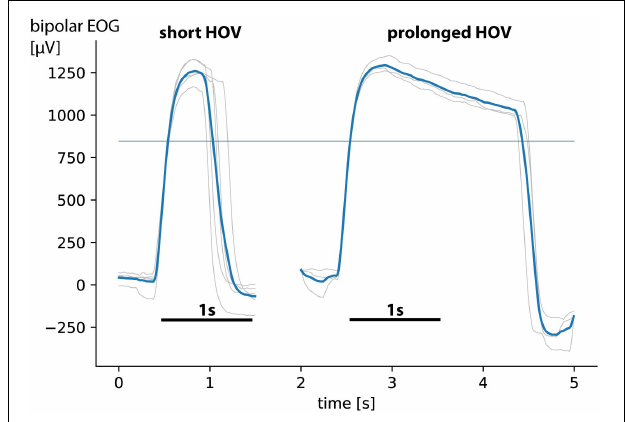
FIGURE 2 | Experimental setup. Participants were equipped with a wireless active-electrode electroencephalography/electrooculography (EEG/EOG) recording system (actiCAP R (cid:13) , LiveAmp R (cid:13) , Brain Products GmbH, Gilching, Germany) and comfortably seated in front of a screen receiving visual feedback. Feedback included information about the task to be executed (in the middle of the screen) and the representation of the left (partly opened yellow circle indicates active exoskeleton) and right exoskeleton (partly opened gray circle indicates inactive exoskeleton) visualizing opening or closing motions. The figure shows an EOG electrode laterally placed to left outer cantus and five EEG electrodes arranged over the left hemisphere to assess Laplace-filtered brain activity at C3.